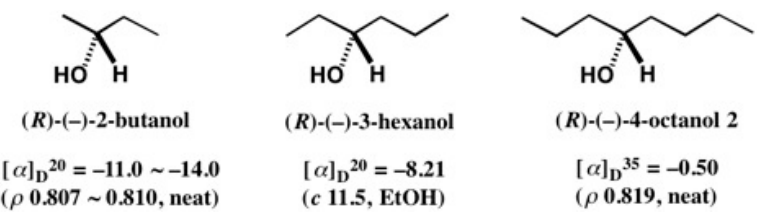
Figure 54. ACs and optical rotation data of alcohol homologs with the structure of CH3(CH2) n - CH(OH)-(CH2) n +1CH3: ( R )-( − )-2-butanol [64], ( R )-( − )-3-hexanol [65], and ( R )-( − )-4-octanol 2 [13].